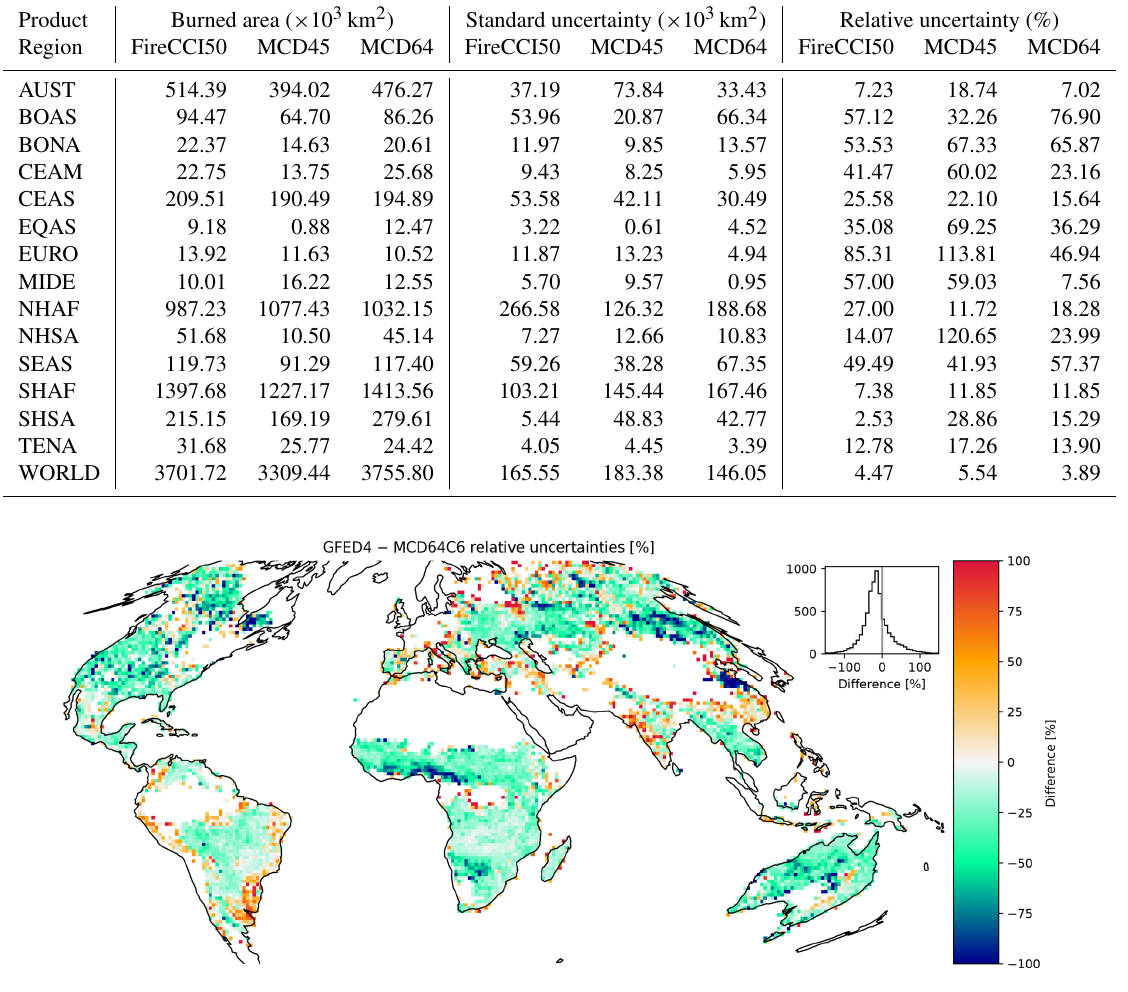
Figure 8. Differences in relative uncertainties between GFED4- and TC-estimated relative